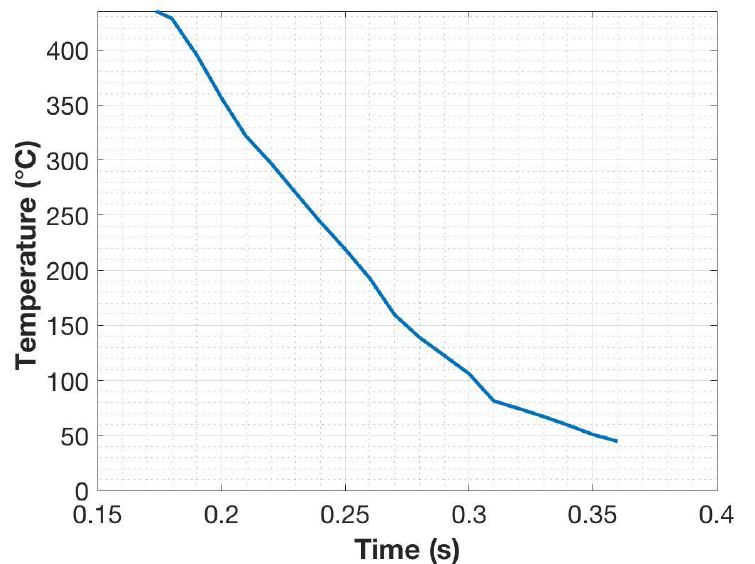
Figure 1. Thermocouple data obtained from the surface of the specimen during quenching of the steel after austenitizing with the Gleeble. Table 1. Mean chemical composition (wt %) (Spectruma GDA 750 Analyzer) of the steel. C Si Mn Cr Ni Ti V Al 0.126 0.72 1.66 0.27 0.038 0.027 0.047 0.054